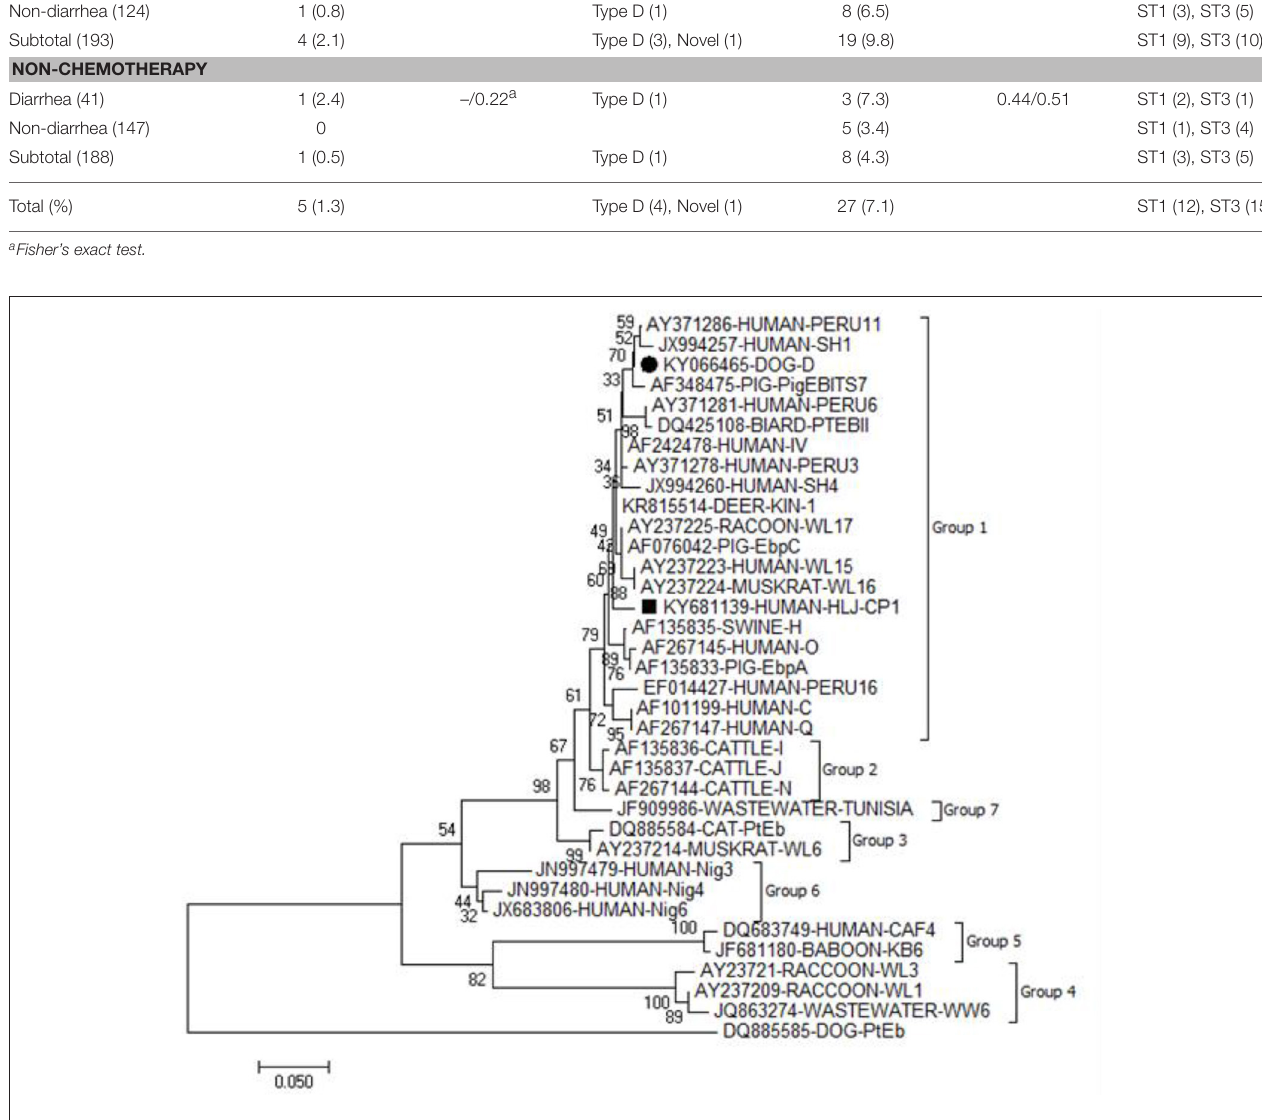
FIGURE 1 | Phylogenetic relationship of the genotypes of E. bieneusi . The relationship between the genotypes of E. bieneusi identified in the present study and known genotypes of E. bieneusi deposited in the GenBank was inferred by a neighbor-joining analysis of ITS gene sequences based on genetic distance by the Kimura 2-parameter model. Each sequence is identified by its accession number, host origin, and genotypes. The numbers on the branches are percent bootstrapping values from 1,000 replicates. The circle and square filled in black indicate known and novel genotypes identified in the present study,